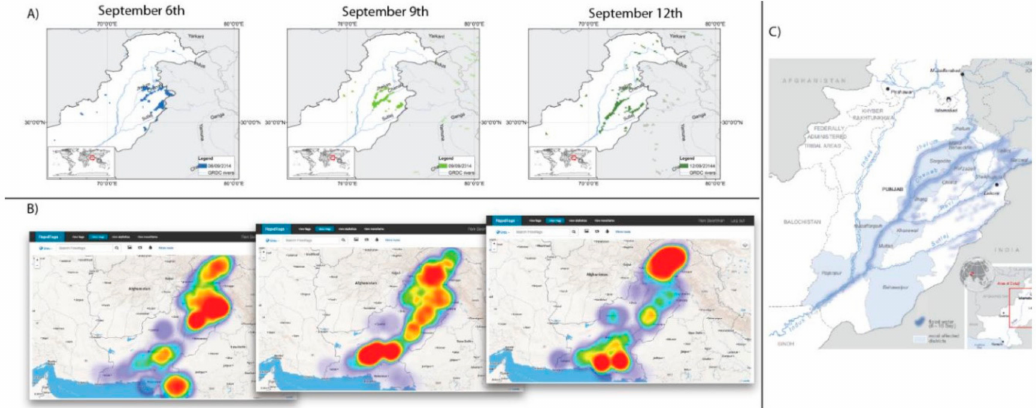
Figure 15. A ff ected flood areas as derived from di ff erent sources in the north of Pakistan: ( A ) flood maps derived from near real-time satellite data ( B ) heat map based on flood-related Twitter activity; and ( C ) inundation map published by O ffi ce for the Coordination of Humanitarian A ff airs (UN-OCHA) in October 2014 [187].